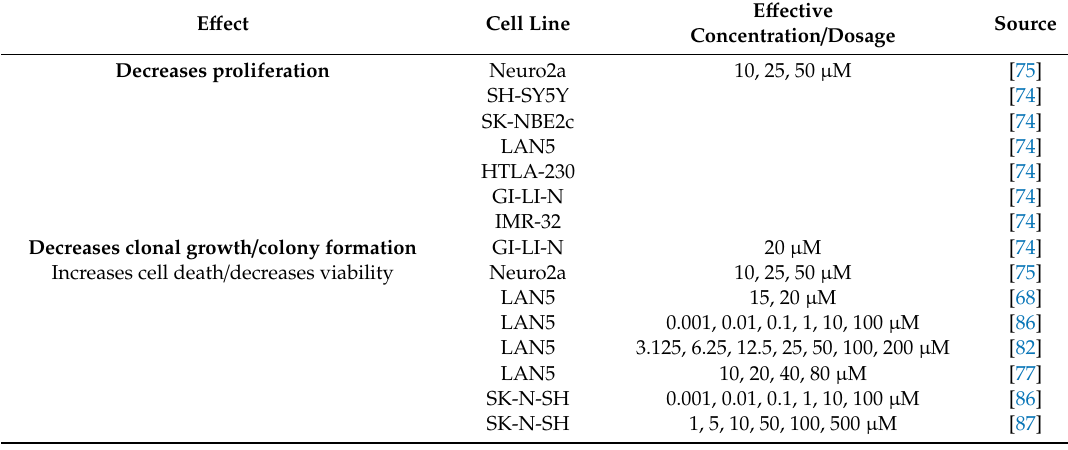
Table 1. Anticancer e ff ects of pure curcumin on NB cell lines. Curcumin modulates genes and proteins that regulate proliferation, apoptosis, cell cycle progression, cell motility, and intracellular glucose metabolism. Downregulations, decreases, and inhibitions are in